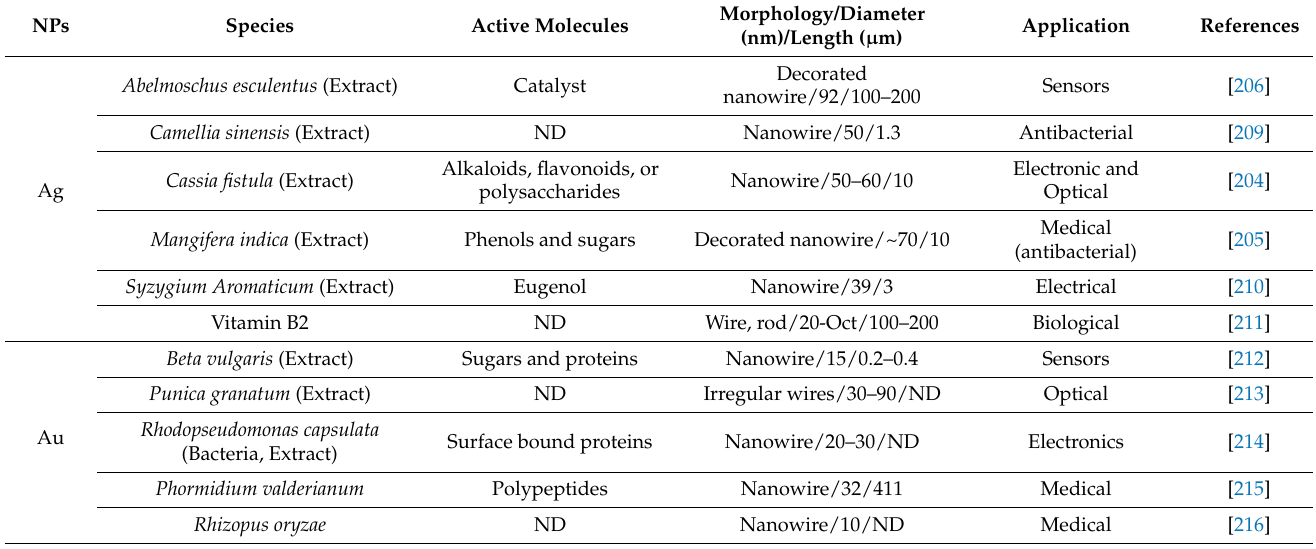
Table 7. 1D Nanomaterials Produced from different plant material or other